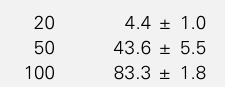
Table 1 - Effect of increas- ing concentrations of alumi- num on human blood plate- let aggregation. Platelets were incubated at 37 o C, Al 3+ solutions were added and aggregation was recorded for 5 min. Data are reported as mean – SEM of 10 independent determina- tions.